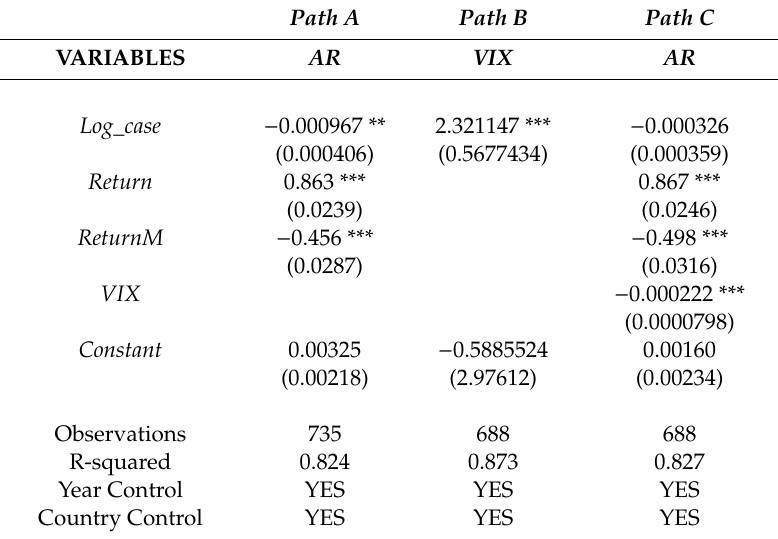
Table 13. Mediating e ff ect of volatility index (VIX). Path A Path